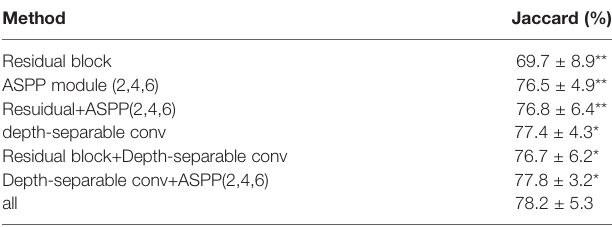
FIGURE 4 | Ablation experiment on different group of module proposed in our paper. TABLE 4 | Results of ablation studies with different components.